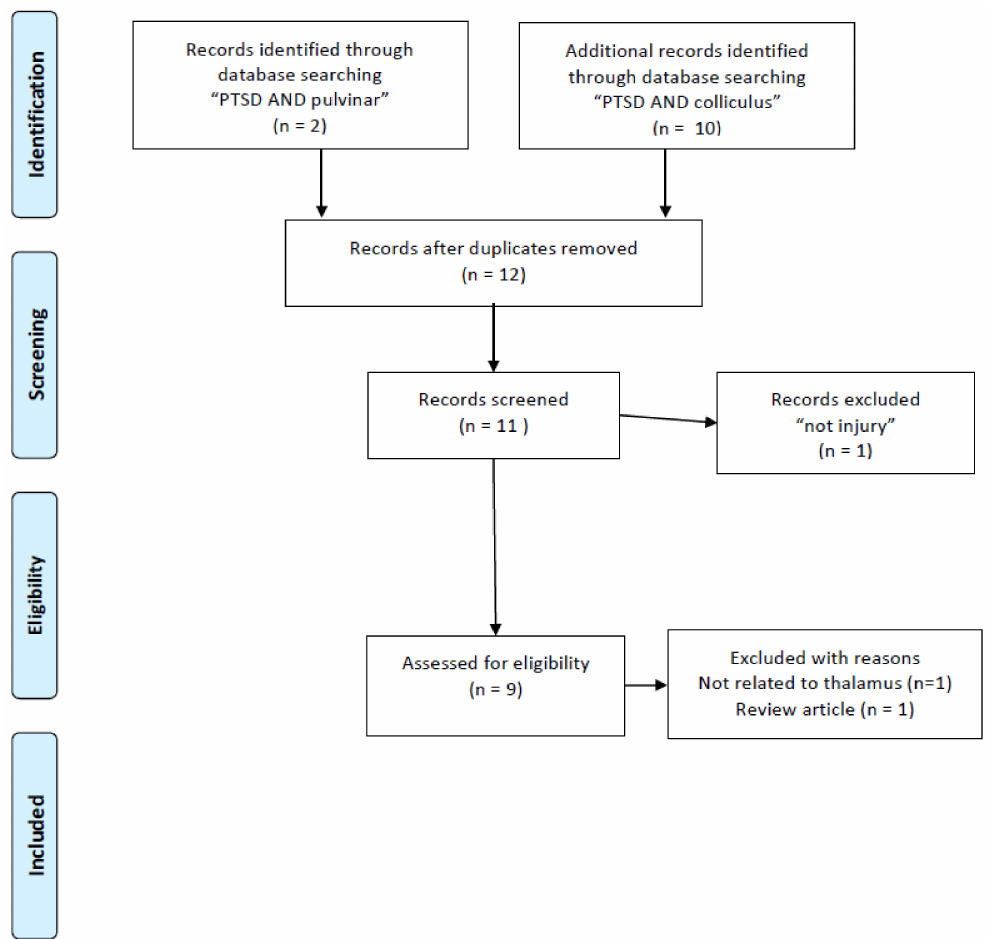
Figure 3. PRISMA flow diagrams [25] for literature research for PTSD targeting retinotectal